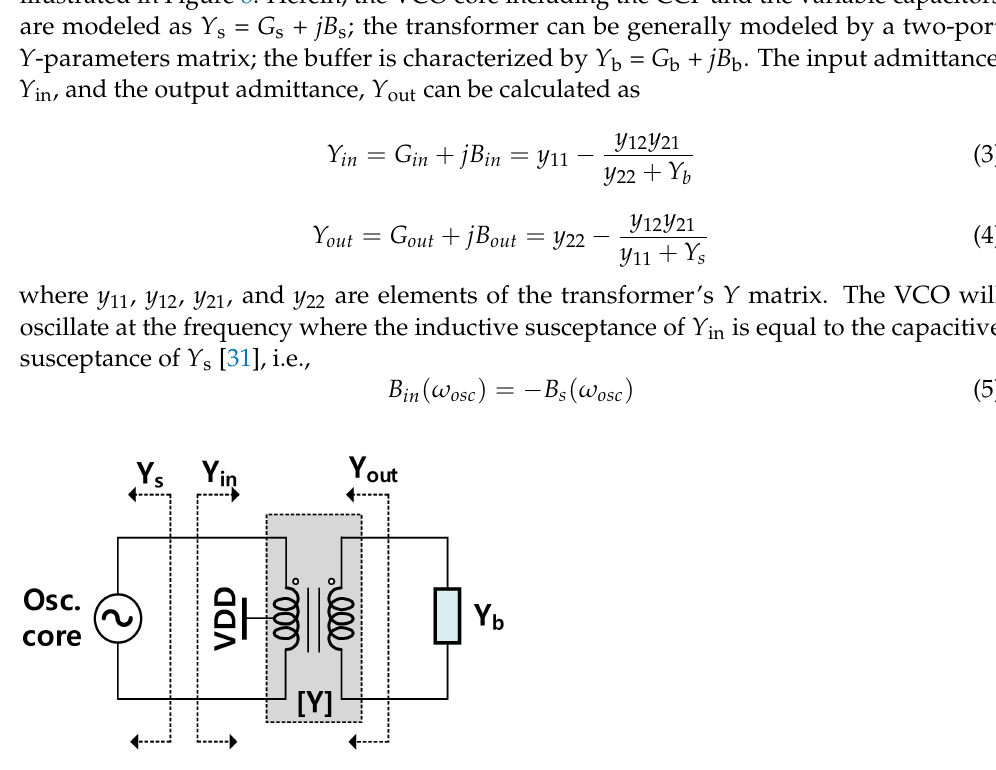
Figure 8. The schematic circuit of the VCO using a transformer at the